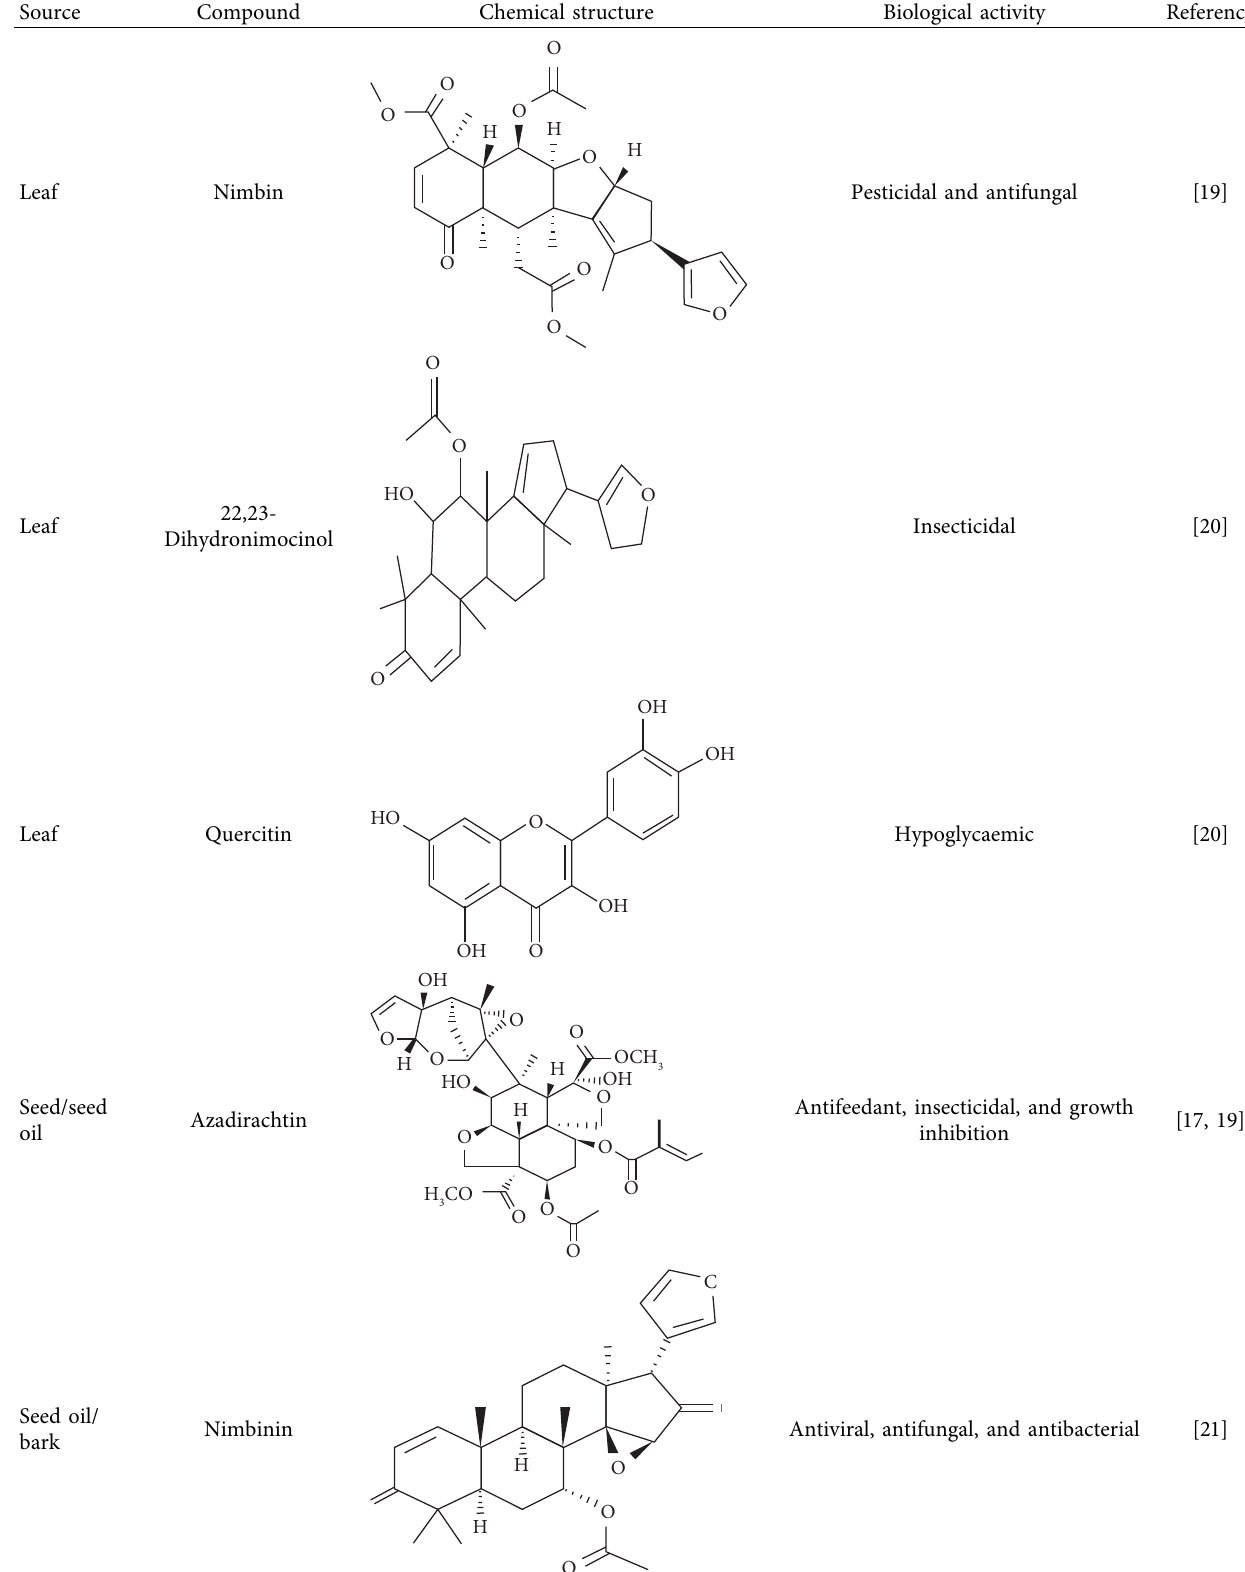
Table 2: Bioactive compounds with chemical structures and biological activities in distinct parts of